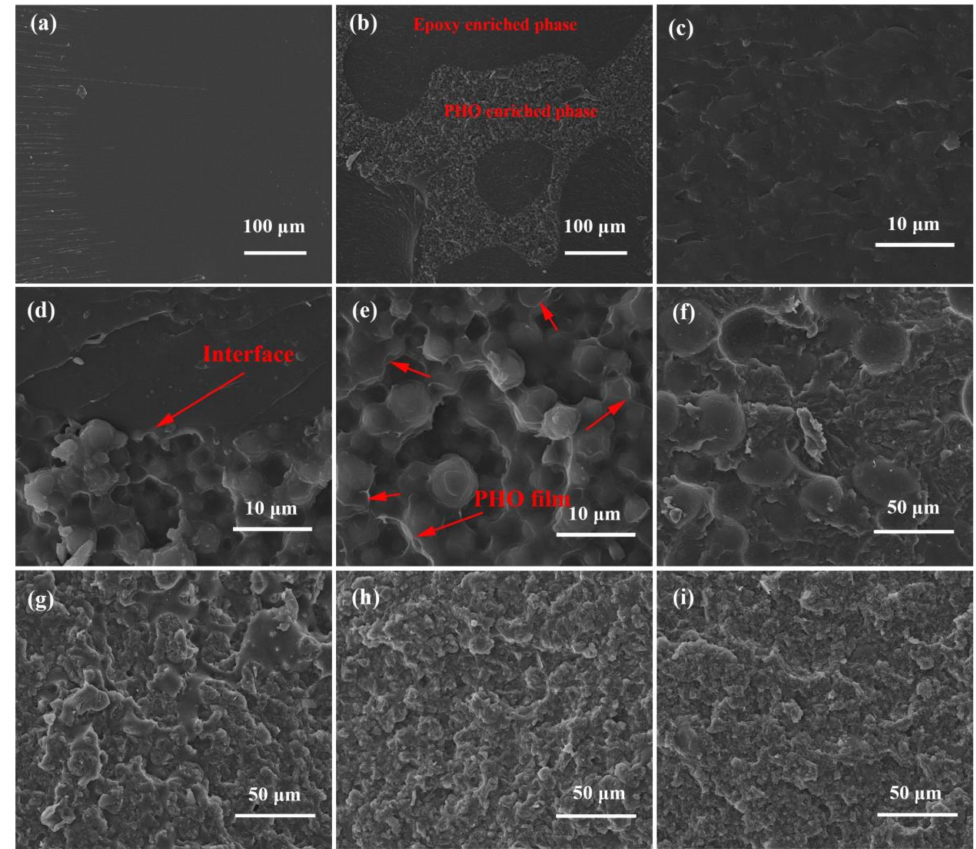
Figure 5. SEM images of different adhesive systems: ( a ) pure epoxy resin; ( b ) Ep/PHO30; ( c ) PHO-enriched phase in Ep/PHO30; ( d ) epoxy resin-enriched phase in Ep/PHO30; and ( e ) interface between two phases in Ep/PHO30, ( f ) Ep/PHO30/nBN5, ( g ) Ep/PHO30/nBN10, ( h ) Ep/PHO30/nBN20, and ( i )